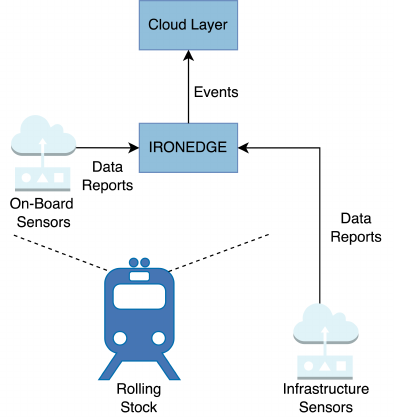
Figure 4. High-level view of sensor integration for Ferrovia